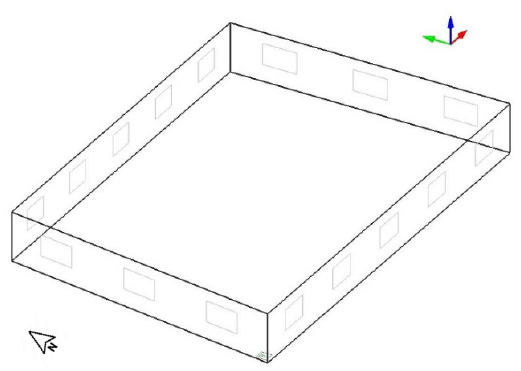
Figure 3. Base case geometric model in DesignBuilder simulation (1:20 scale).